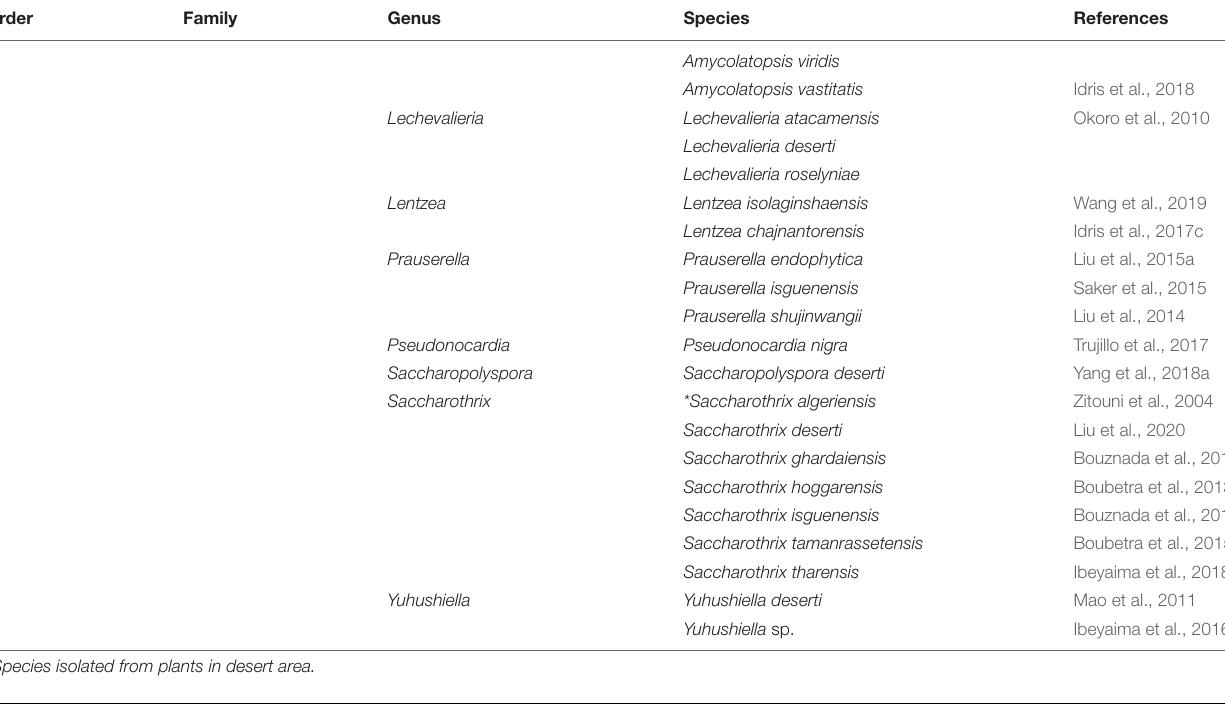
*Species isolated from plants in desert area.